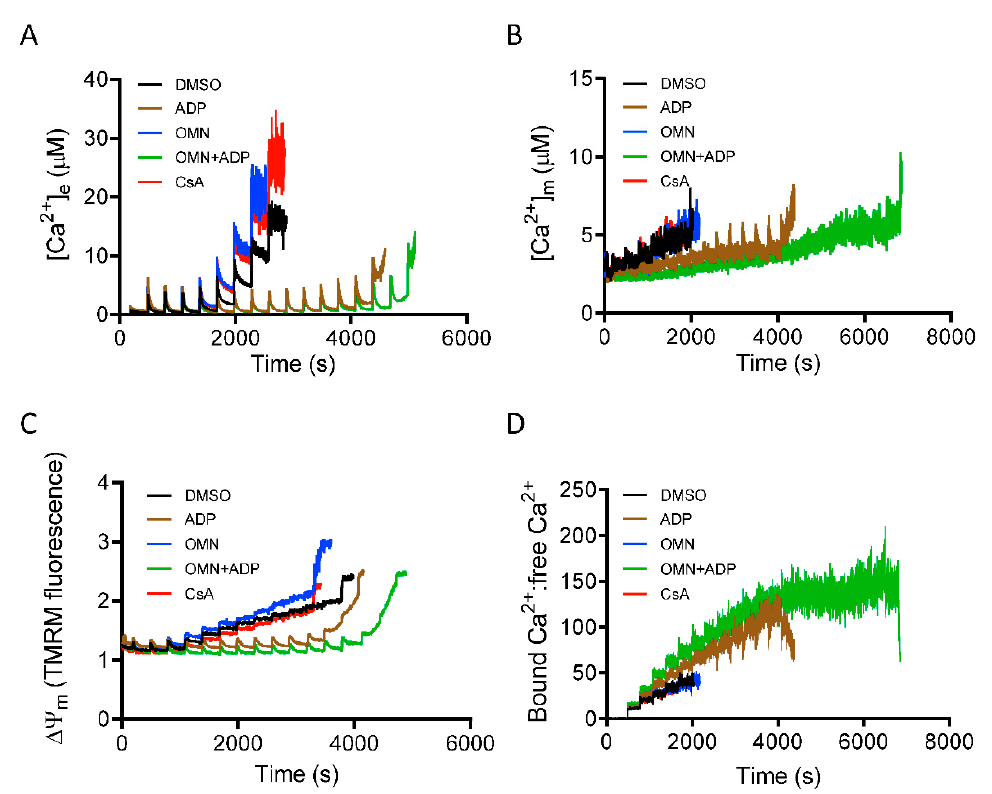
Figure 7. E ff ect of P i on CsA-induced mitochondrial Ca 2 + handling and bioenergetics. Time course of [Ca 2 + ] e ( A ), [Ca 2 + ] m ( B ), ∆Ψ m ( C ), and matrix-bound Ca 2 + :free Ca 2 + ( D ) during consecutive additions of 20 µ M CaCl 2 to a suspension of P i -depleted mitochondria, pre-exposed to DMSO (control), CsA, ADP, OMN, or OMN + ADP.